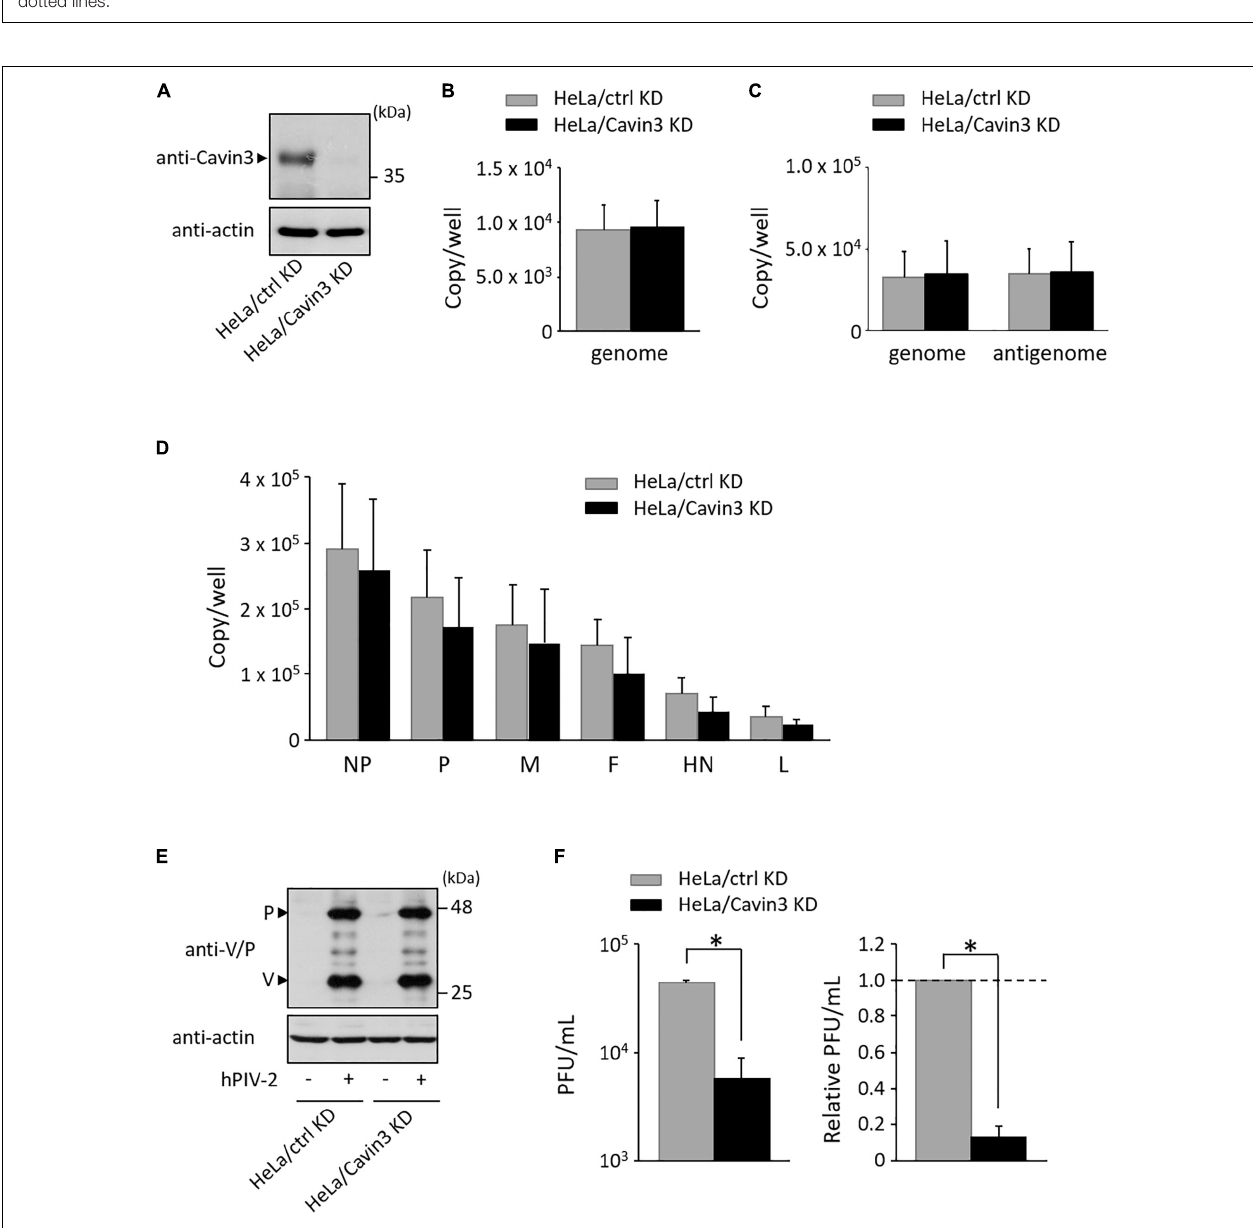
FIGURE 5 | Effects of Cavin3 on hPIV-2 growth. (A) Lysates of the indicated cell lines were subjected to immunoblot using anti-Cavin3 pAb. Actin was used as a loading control. (B) HeLa/ctrl KD and HeLa/Cavin3 KD were incubated with hPIV-2 at an MOI of 1 for 60 min. The cells were then washed with PBS, and total RNA was extracted using Isogen. Copy numbers of hPIV-2 genome were measured by qRT-PCR. The data are the means from six independent experiments. Error bars indicate standard deviations. (C,D) HeLa/ctrl KD and HeLa/Cavin3 KD were infected with hPIV-2 at an MOI of 1 for 1 day. Total RNA was extracted and copy number of hPIV-2 genome and antigenome (C) or mRNAs (D) were measured by qRT-PCR. (E,F) HeLa/ctrl KD and HeLa/Cavin3 KD were infected with hPIV-2 under the same conditions as in (C) . The cell lysates were subjected to immunoblot using anti-V/P mAb (E) . Actin was used as a loading control. The amount of viruses in the culture supernatants was measured by plaque assay (F) . The values of PFU/mL are shown as the means from three independent experiments. Data are also shown as relative PFU/mL values (HeLa/ctrl KD = 1). * P < 0.05, compared to values of HeLa/ctrl KD. Error bars indicate standard deviations.